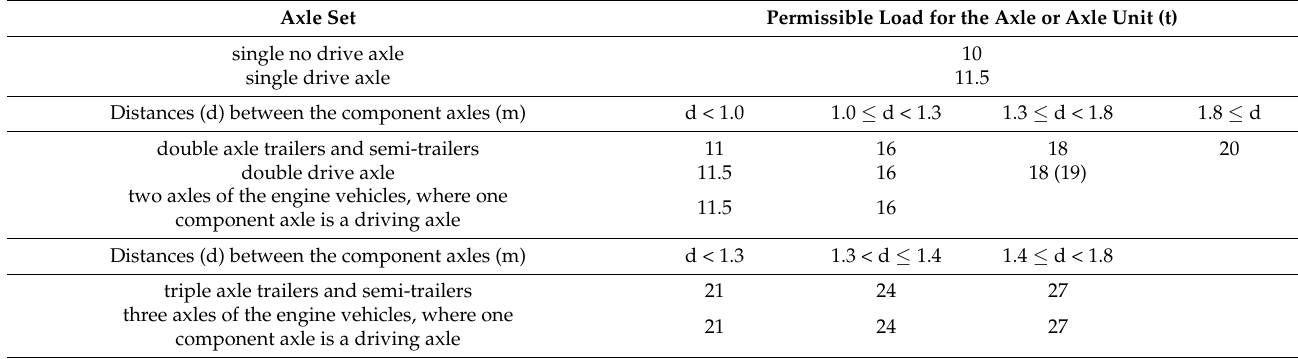
Table A1. Permissible axle load for the transport unit in